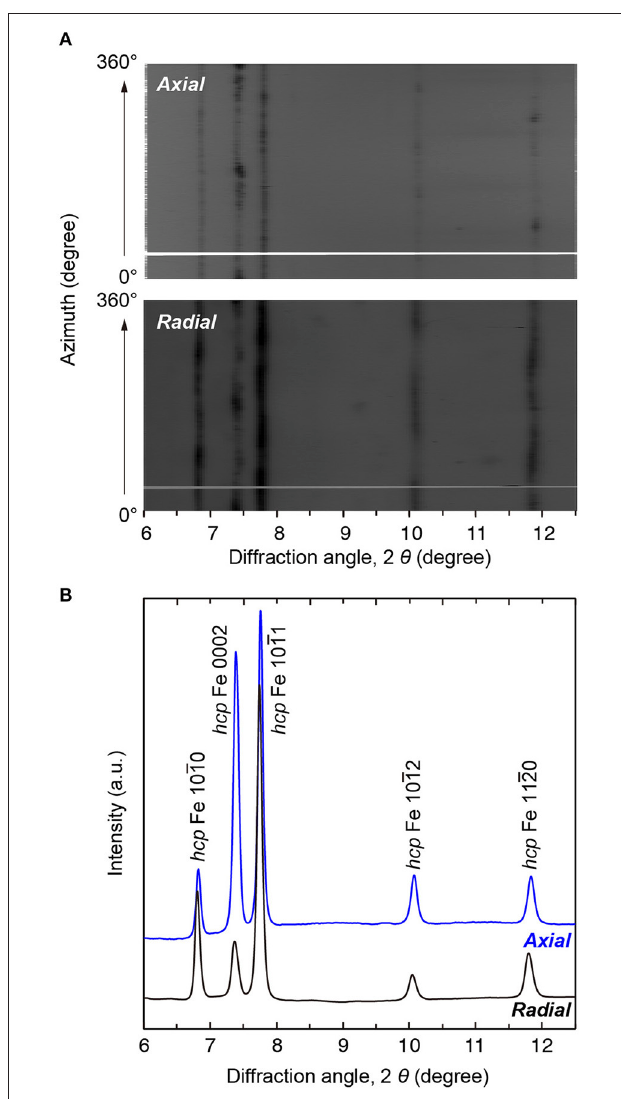
FIGURE 6 | XRD patterns of hcp iron obtained at 41.6 GPa and 300K in Run #7. (A) Unrolled XRD images of hcp iron measured in axial (upper panel) and radial (lower panel) geometries. (B) Integrated XRD patterns of hcp iron measured in axial (blue) and radial (black) geometries. Wavelength of incident X-ray was 0.247 Å.